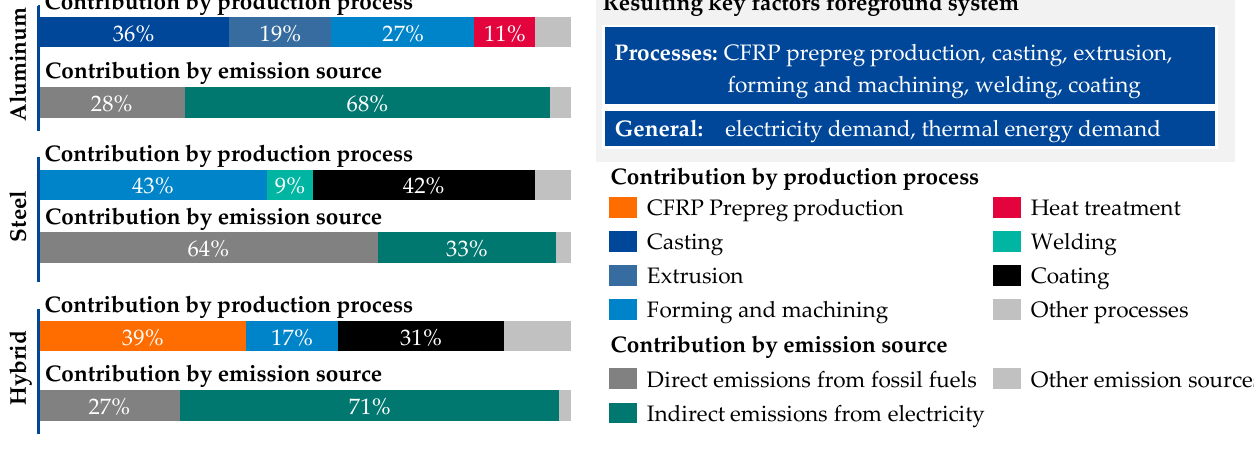
Figure 6. Key factor analysis for the foreground system based on a gate-to-gate perspective showing the relative contribution of each key factor. Identified key factors for the foreground system are the energy intensive production processes and the energy demand for the production stage.